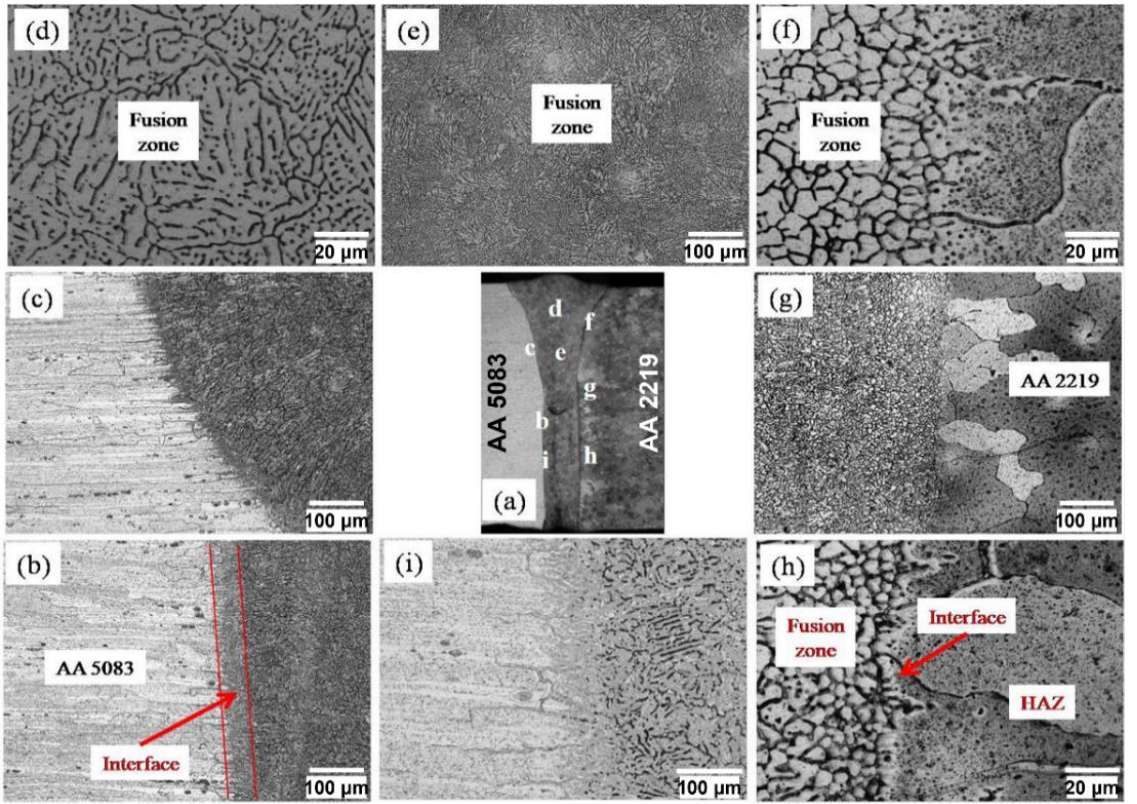
Figure 5. Optical microstructures of AA 2219-AA 5083 EB weld joint ( a ) macrostructure; ( b , c ) FZ interface at AA 5083 side at high and low magnifications, respectively; ( d , e ) FZ at high and low magnifications, respectively; ( f , g ) FZ interface at AA 2219 side at low and high magnifications, respectively; ( h , i ) fusion interface of AA 2219 side and AA 5083 side, respectively, at high magnification. Elemental distribution across fusion interfaces towards the AA 5083 and AA 2219 sides obtained by EPMA are presented in Figures 6 and 7, respectively. The variation of different alloying elements across the fusion interface along path XY (depicted in Figure 6b) demar- cates both the FZ and the PMZ/HAZ. The weight percentage of Mg is 5% in HAZ/base material of AA 5083 side, while in the FZ, the same is found to be varying from 2 to 8%. The lower weight percentage could be due to the evaporation of Mg in the presence of high-power density prevailing in the keyhole of the EB-welding process. The local increase in Mg concentration in the FZ is mainly because of dilution from AA 5083. It can be observed that at the fusion interface near the AA 5083 side, there is no sudden change in the concentration of alloying elements. However, at the fusion interface near the AA 2219 side, there is a steep increase in the concentration of Cu, i.e., up to 17% (see Figure 7b). At the location where Cu concentration increased, %wt. of Al is reduced. This observation is discussed in detail in a later part of this